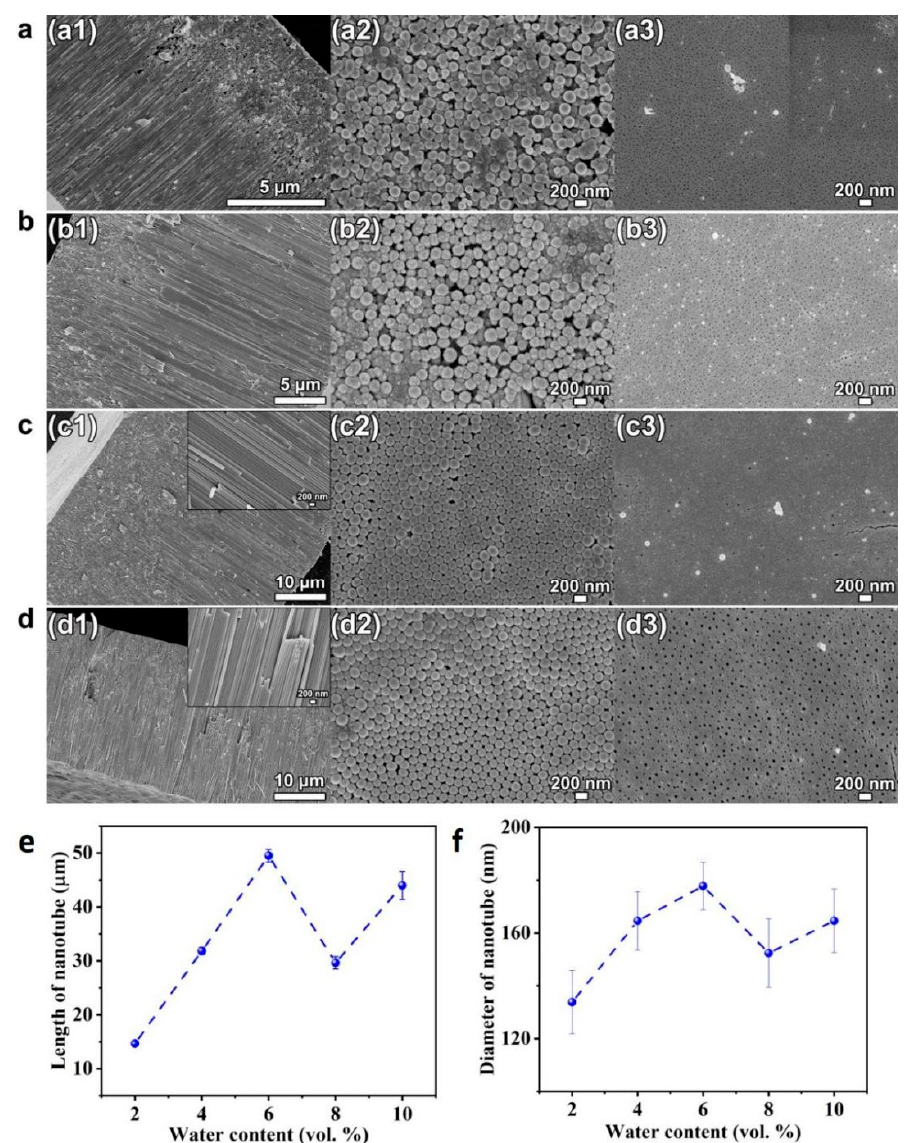
Figure 6. ( a – d ) SEM images of cross-sectional (a1 – d1 ), bottom ( a2 – d2 ) and top views ( a3 – d3 ) of the HEO nanotube arrays formed under 60 V in the ethylene glycol solution containing 0.1 mol/L NH 4 F and different amounts of DI water: ( a ) 2 vol.%, ( b ) 4 vol.%, ( c ) 6 vol.% and ( d ) 8 vol.% after the anodization for 4 h; ( e ) Changes in nanotube length and diameter ( f ) with water